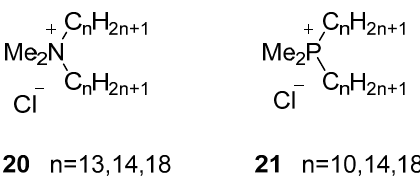
Figure 5. Ammonium and phosphonium-based ILCs with two long aliphatic tails.